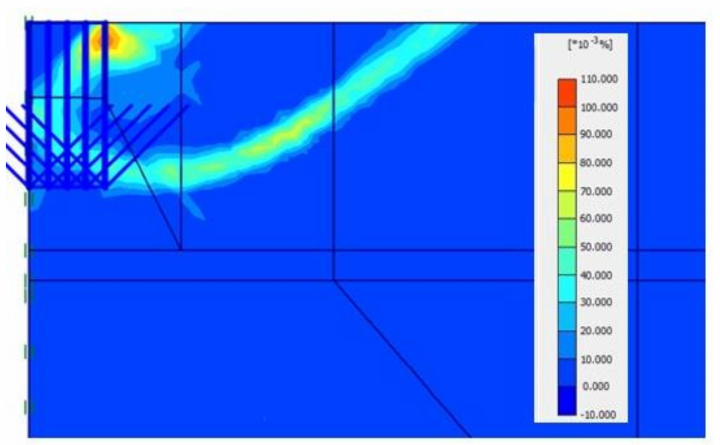
Figure 5. Incremental shear strain at failure for the case of a homogeneous soil foundation made of sand with ϕ (cid:48) = 35 ◦ and ψ (cid:48) = ϕ (cid:48) (B = 1